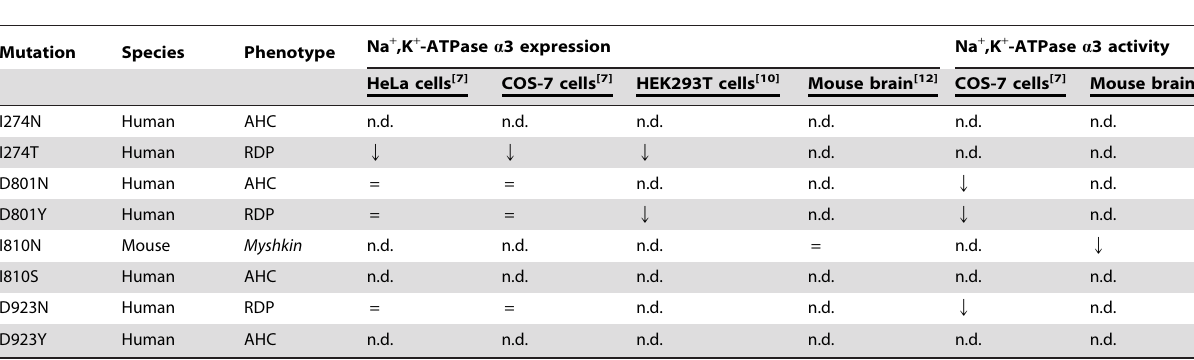
Table 1. Na + ,K + -ATPase a 3 mutations selected for structural modelling.